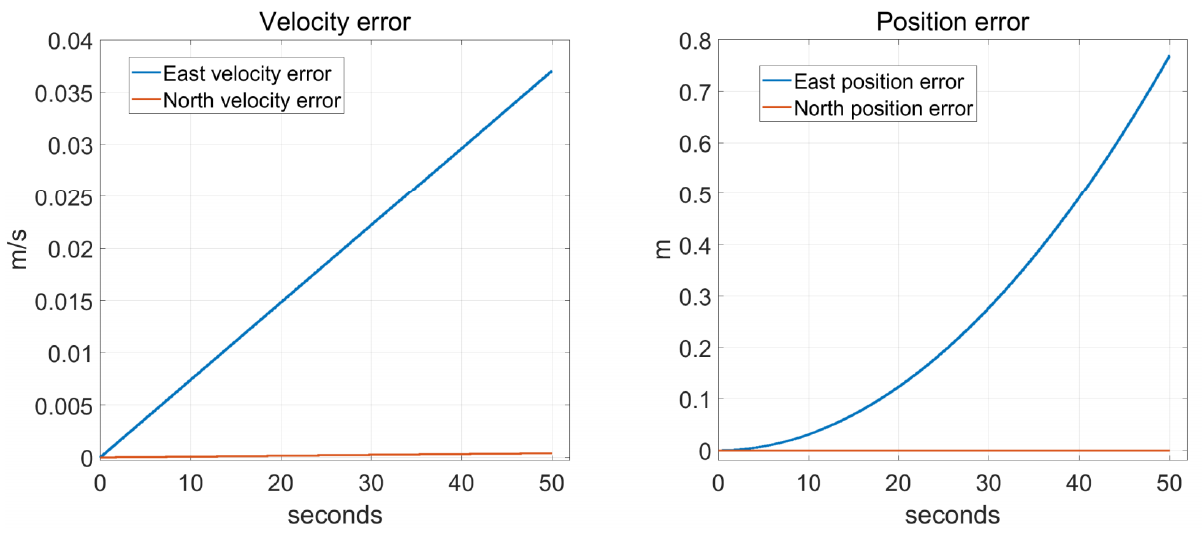
Figure 3. Simulate navigation